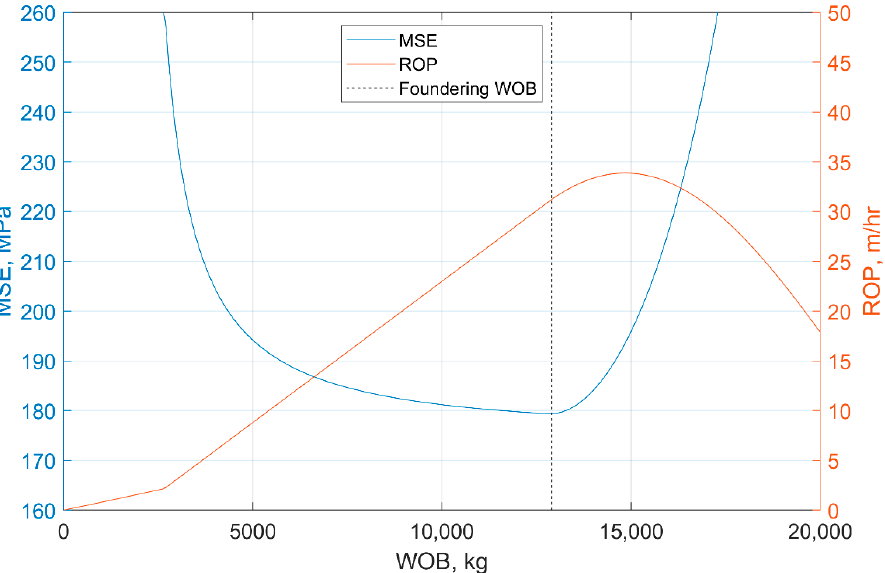
Figure 4. MSE and ROP as functions of WOB , illustrated for a constant RPM value of 90.